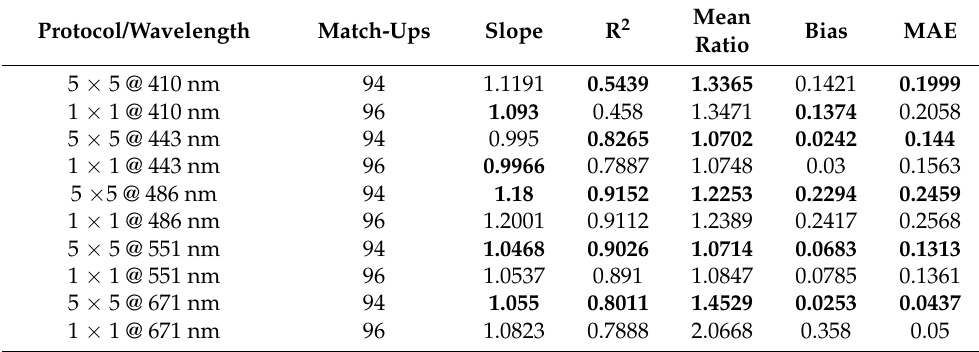
Table 5. Venise data, strict protocol. June 2014–May 2019. Values closest to one in bold, for slope, R 2 , and mean ratio. Lowest values in bold for bias and mean absolute error.